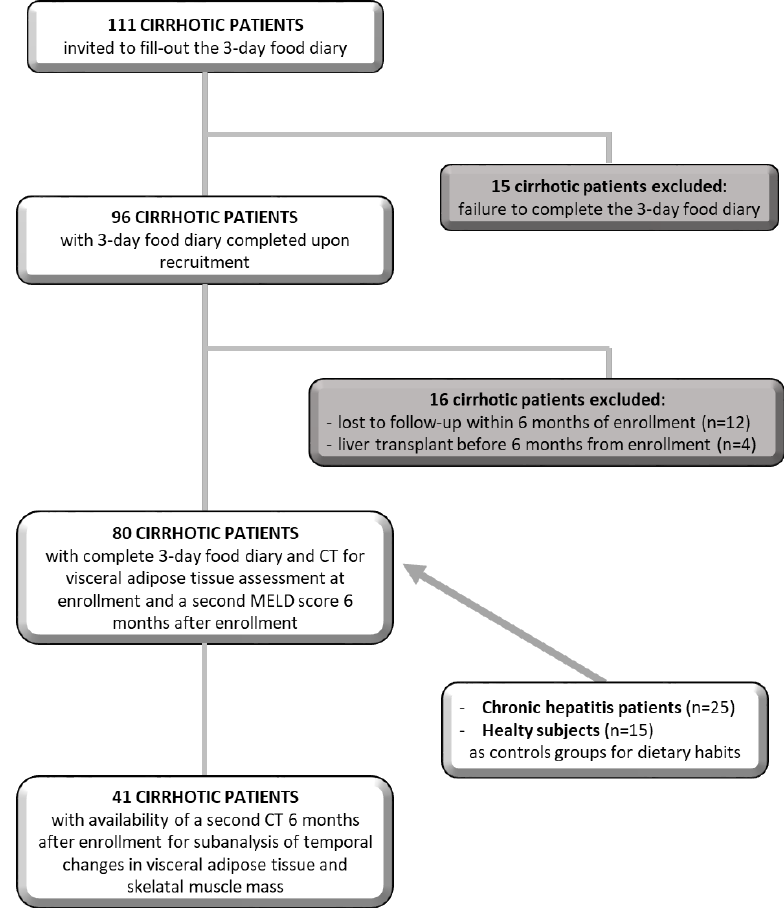
Figure 1. Schematic diagram depicting the study population .